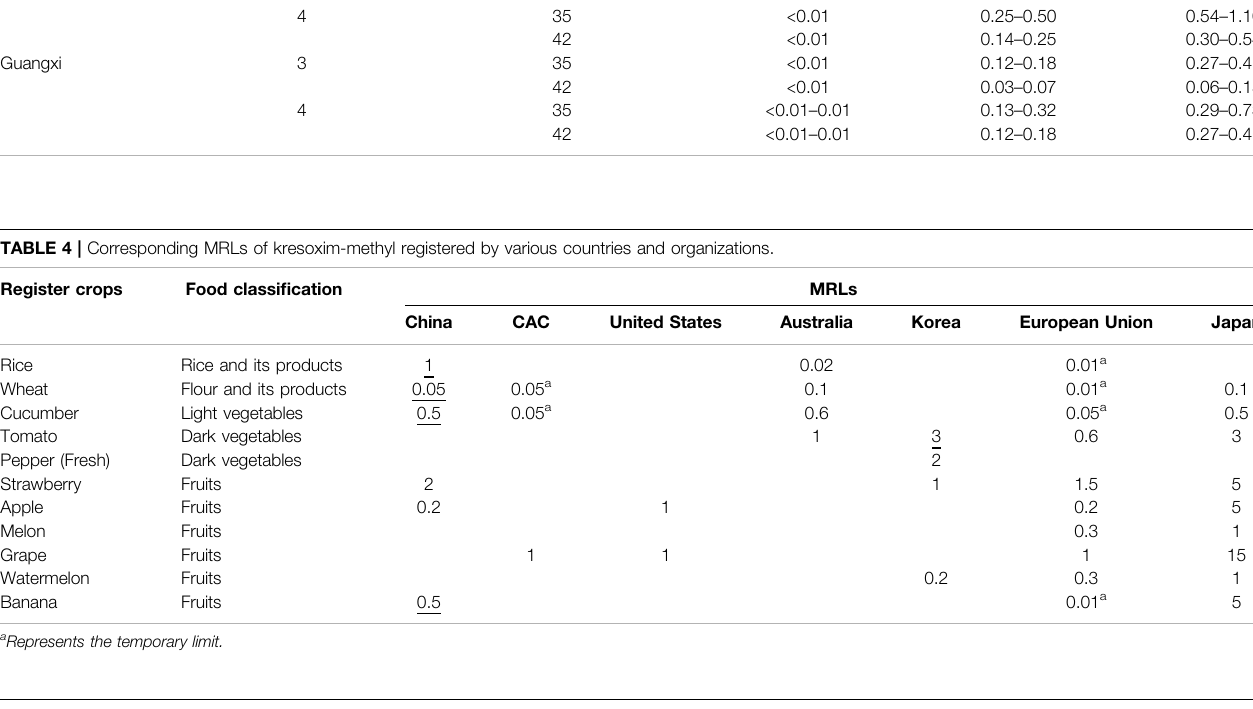
TABLE 5 | Risk probability of kresoxim-methyl in